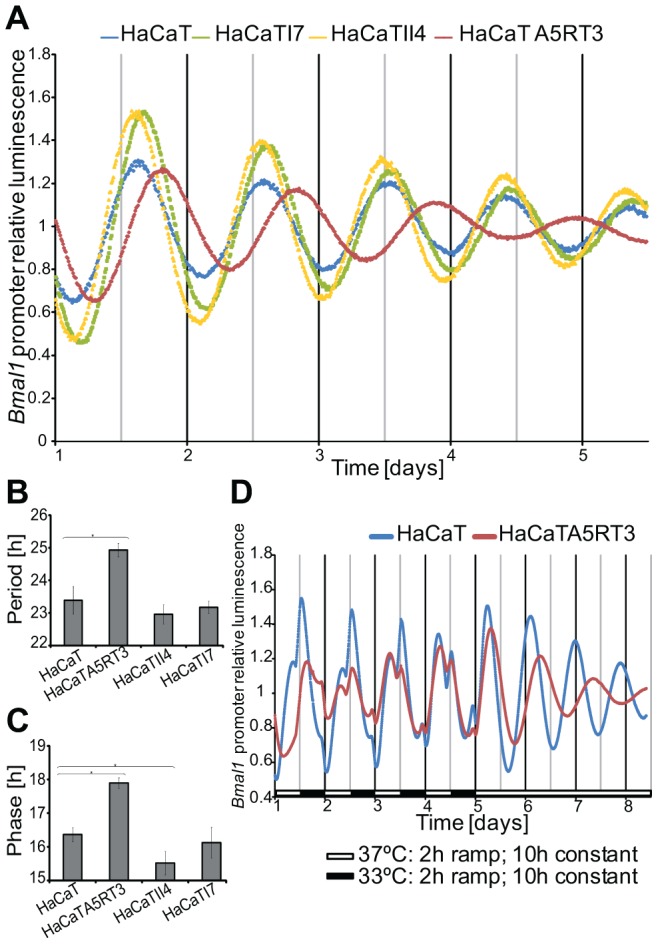
Differential circadian phenotypes of human keratinocytes and their Ras-transformed variants.
Bmal1-Luciferase bioluminescence was recorded for 5 days after dexamethasone synchronization (A). Representative results from five independent experiments are shown (HaCaT II4 n = 3). Normal human keratinocytes display an average period of 23.4±0.4 hours with a peak phase at 16.4±0.2 hours after of synchronization (B, C). HRAS transformed HaCaT A5RT3 show a significantly longer period (HaCaT A5RT3 24.9±0.2 hours p<0.05, Student's t-test) and a significant phase delay of approximately 1.5 hours (p<0.05, Student's t-test). An significantly earlier phase of 0.24 and 0.85 hours was observed in HaCaT I7 and HaCaT II4 cell lines, compared to normal keratinocytes (HaCaT II4, p<0.05, Student's t-test). (D) Phase delay of H-Ras-transformed human keratinocytes upon temperature entrainment. HaCaT and HaCaT A5RT3 were entrained with temperature cycles for 4 days consisting of 10 hours 37°C and 10 hours 33°C with 2-hour ramps and subsequently released to constant 37°C. Bioluminescence of the Bmal1-driven luciferase reporter was recorded for at least 8 days. Shown are representative detrended data from two independent experiments.